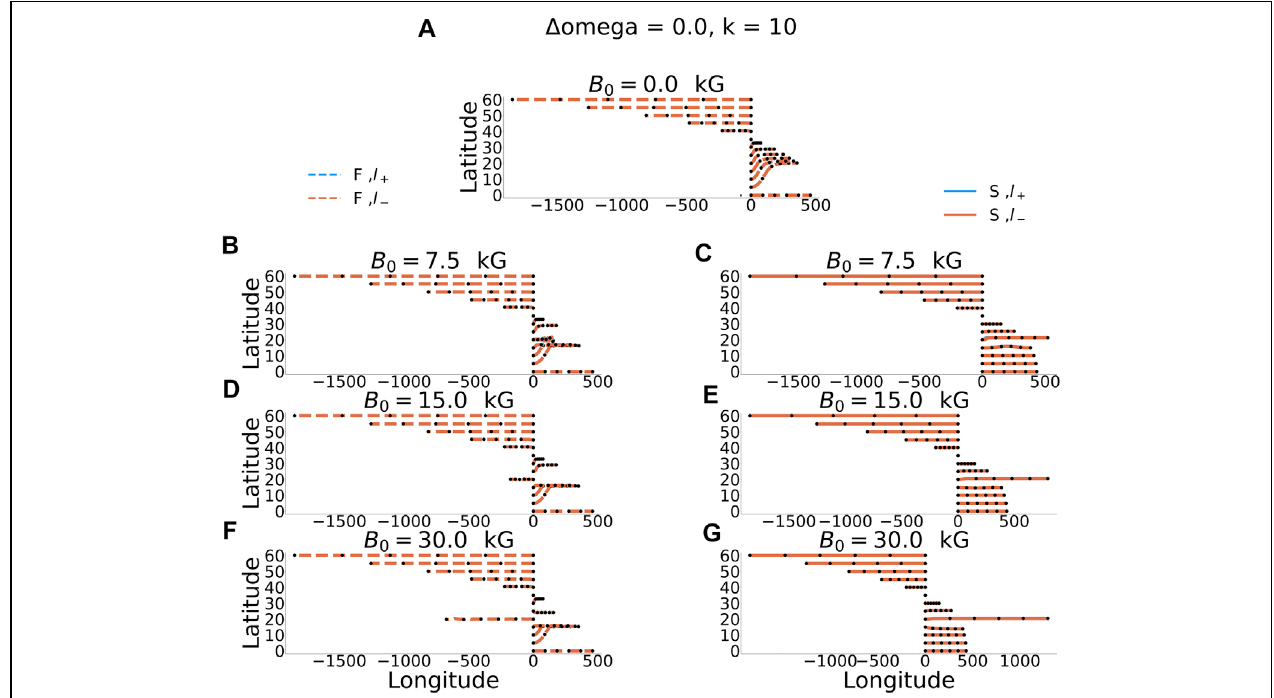
FIGURE 4 | Similar to Figure 3 , but for the narrow band toroidal magnetic field.